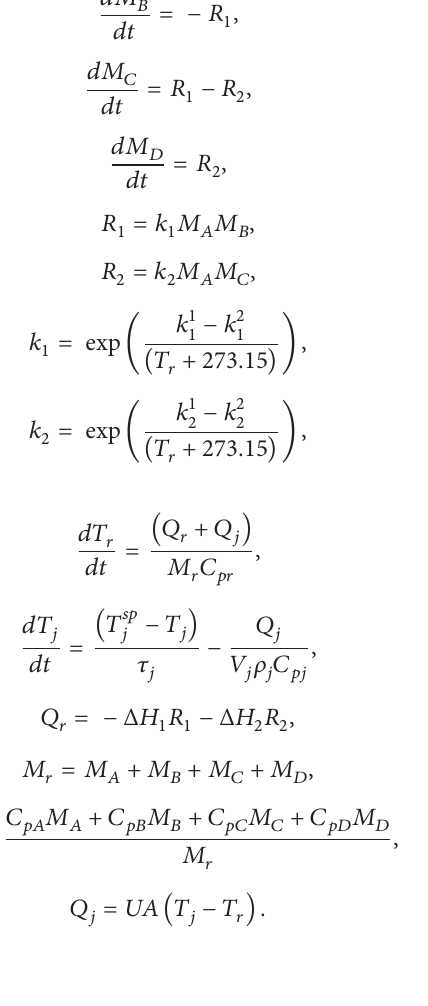
Figure 2: Types of